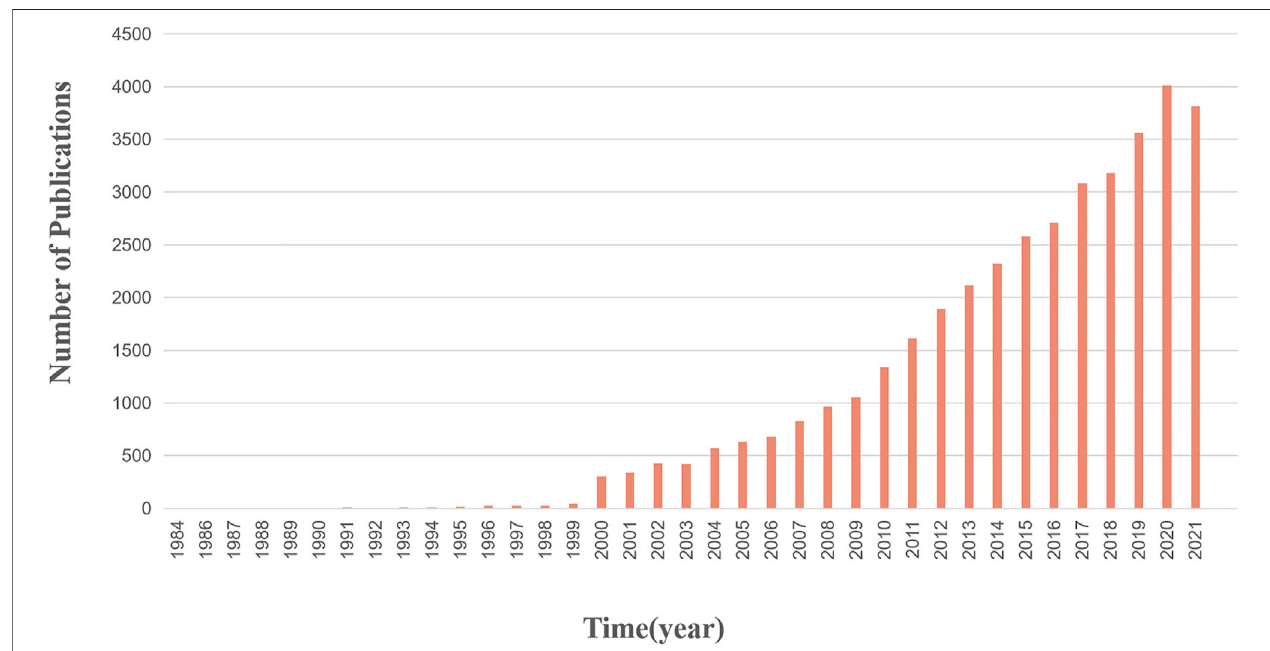
FIGURE7| Annual trendchart ofscienti fi carticles inthe fi eld ofanticancer natural products. The publication ofscienti fi carticles fi rststartedin 1984and reached a peak of 4,013 in 2020.